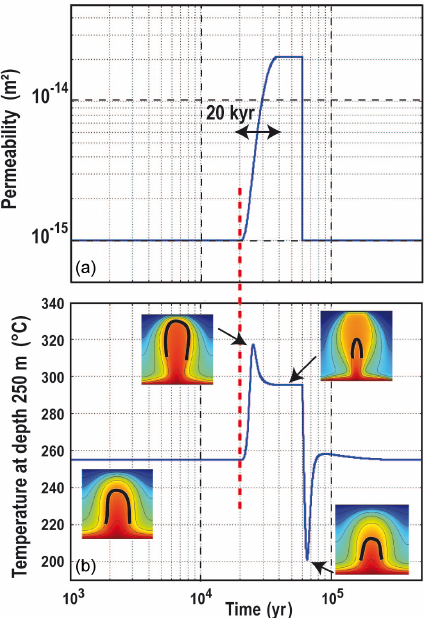
Figure 4. Effect of a time-dependent permeability increasing by a factor of 20 in 20kyr. The finger-like geometry (lower left pat- tern) evolves towards a bulb-like geometry (upper right pattern). The temperature profile (b) shows short-duration heating and cool- ing events. The thick black contour on convective patterns corre- sponds to the 300 ◦ C isotherm. The color bar (not shown) is the same as in previous